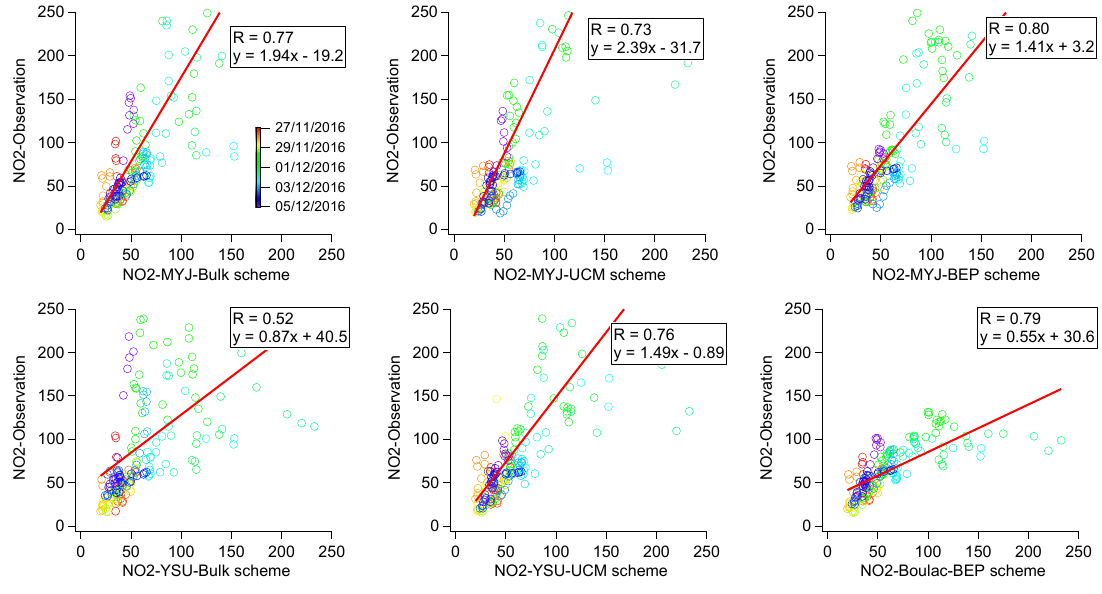
Figure 18. Liner fit between the observed and modelled NO 2.